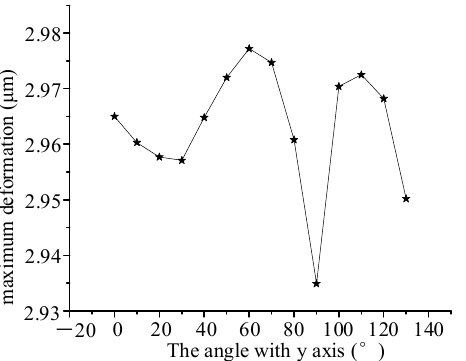
Figure 10. The maximum deformation at different loading positions under milling condition.